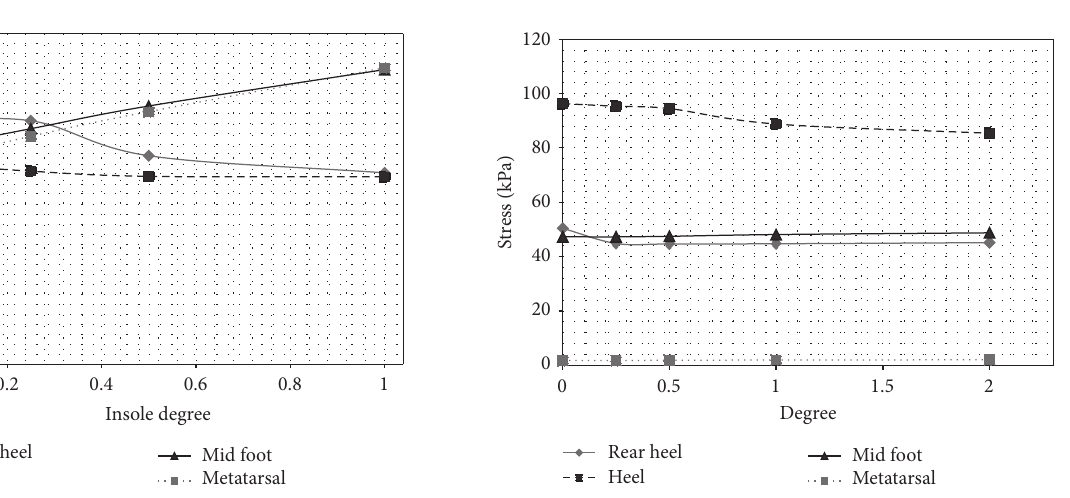
Figure 5: Variation of maximum stress value by changing the degrees in metatarsal, mid foot, and heel regions for custom-molded insole. Increase of insole degree (or the heel height) does not necessarily reduce the maximum stress in foot; the recommended range is around 0.2 ∘ to 0.4 ∘ .